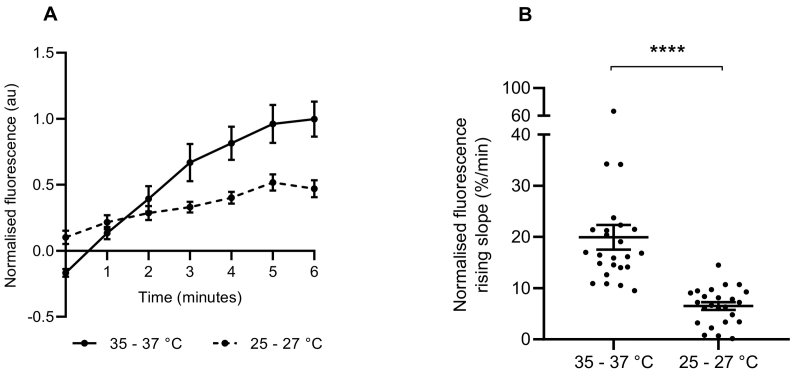
NTUA uptake into noradrenergic nerve terminals is temperature-dependent in the mouse left atrial appendage.The trace of NTUA uptake into terminals was shallower in cooler temperatures during the 1:20 NTUA test period compared to physiological temperatures (A). The gradient variables were extracted and quantified in B. The rate of NTUA uptake was reduced by three-fold when the bath temperature was lowered by 10 °C prior to and during the test period (B) 35–37 °C (n = 4, nt = 24) vs. 25–27 °C (n = 4, nt = 24).Data presented as mean ± SEM. **** denotes p < 0.0001. Mann-Whitney U test.